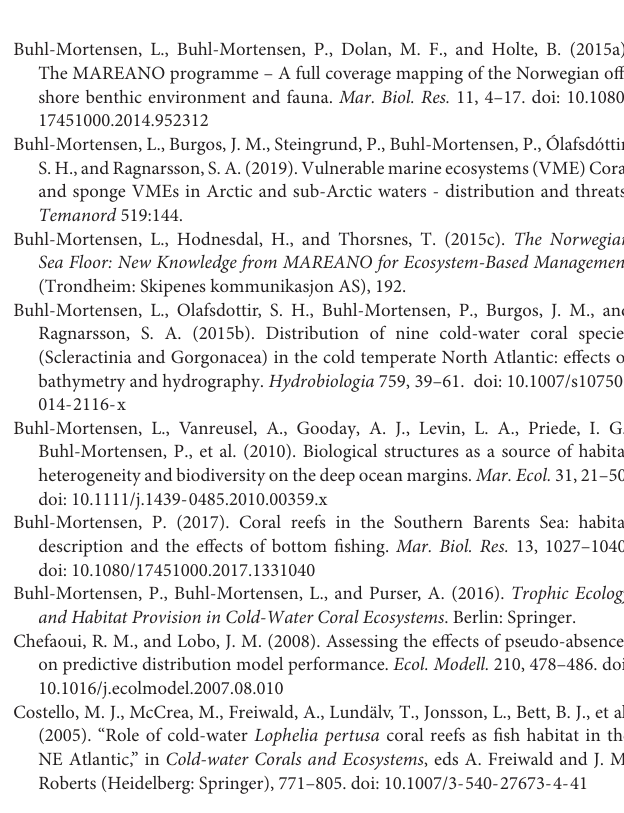
FIGURE S1 | Current-aspect angle. For same direction as aspect: 0 ◦ , toward the aspect: 180 ◦ , perpendicular to the aspect: 90 ◦ . FIGURE S2 | Rose diagrams for current-aspect angle (number of occurrences in five sections). FIGURE S3 | Scatterplot matrix produced with the MGET plug-in for ArcGIS on all coral presence points for all continuous variables. The Spearman’s Rank ρ value for each variable pairing is in the upper right half, distribution of each variable in the diagonal, and a scatterplot with a line of best fit in the lower left half. Correlation pairings with ρ ≥ 0.75 are outlined; variables eliminated for the Maxent analysis are highlighted (from top-left to bottom-right): Max current speed, Ln ruggedness, max salinity, min salinity, and max